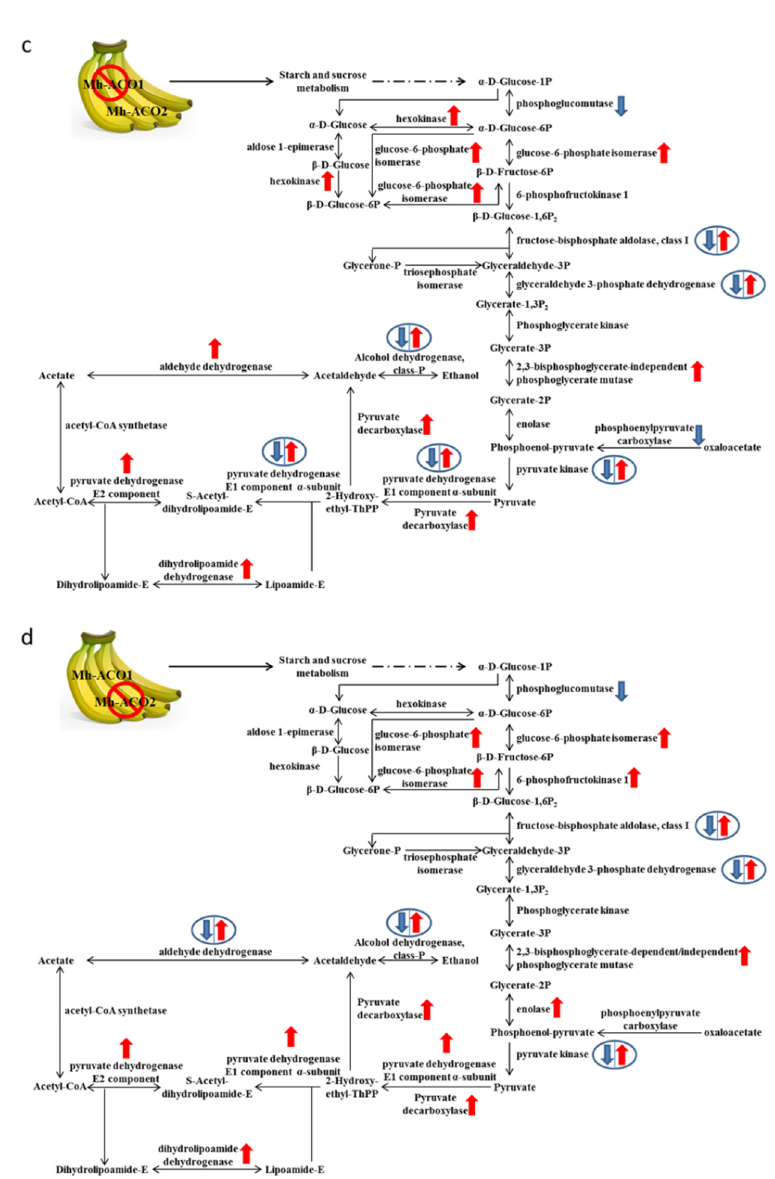
Figure 2. Schematic expression patterns of genes related to carbohydrate metabolism. Enzyme names are indicated between metabolites. Arrowheads with red or blue color indicate differential up- or down-regulation compared with the control WT, respectively. The red and blue arrowheads encircled by a ring indicate that both up- and down-regulated contig ID’s were found. ( a ) Starch and sucrose metabolism pathway in the sample of As1 versus WT control (As1-vs-WT). ( b ) Starch and sucrose metabolism pathway in the sample of As2 versus WT control (As2-vs-WT). ( c ) Glycolysis and gluconeogenesis pathway in the sample of As1-vs-WT. ( d ) Glycolysis and gluconeogenesis metabolism pathway in the sample of As2-vs-WT. WT, As1, and As2 represent untransformed control, Mh-ACO1, and Mh-ACO2 RNAi transgenic bananas, respectively.